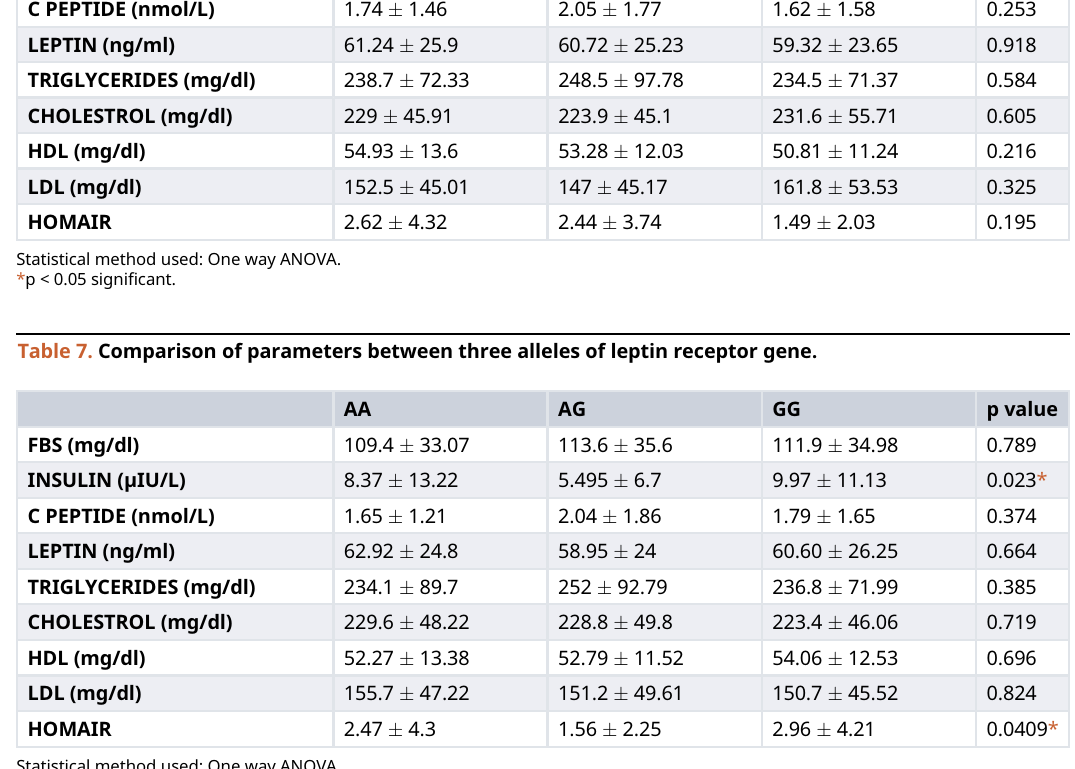
comparison to subjects in group 2 (p < 0.0001). Fasting leptin levels were insignificantly higher in insulin resistant cases as compared to the sensitive (61.62 (cid:1) 29.23 and 59.88 (cid:1) 22.25). Lipid profile indicators such as total cholesterol, low density lipoprotein, and high-density lipoprotein levels did not differ significantly between the groups as shown in Table 4. Serum leptin showed highly significant negative correlation with Homeostatic Model Assessment for Insulin Resistance (HOMAIR) (r = -0.316) (p-0.006), whereas C peptide showed high significant negative correlation with total cholesterol (r = -0.394), LDL(r = -0.372) and positive significant correlation with HOMAIR (r = 0.283) (Table 5) with p values being 0.001, 0.001, and 0.015 respectively (Table 4). On comparing biochemical markers among subjects of group 1, insulin, C peptide, leptin, and lipid parameters did not differsignificantly betweenthe genotypes AA,GG, andAG of theleptin gene and asignificant difference infasting blood sugar was observed (p = 0.0173) (Table 6). C peptide, leptin, and lipid indicators showed no significant differences when comparedwith differentgenotypesoftheleptin receptor(LepR) gene,homozygous recessiveAA,heterozygous AG,and homozygous dominant GG. However, a significant difference in insulin levels was observed (p value-0.023) (Table 7).